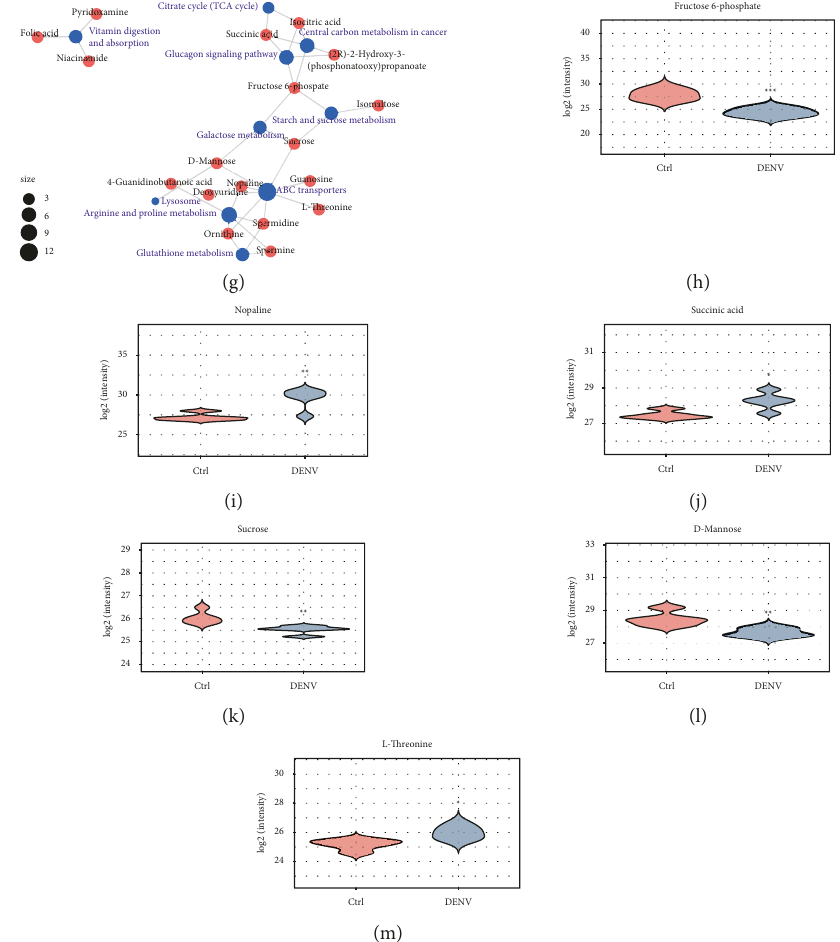
Figure 1: Urinary metabolite profiles reflect characteristics of DENV infections. Score plot of principal component analysis (PCA) performed using urinary metabolite data for all samples in (a) the positive-ion mode and (b) the negative-ion mode. Score plot of partial least squares (PLS) regression performed using metabolite data from samples in (c) the positive-ion mode and (d) the negative-ion mode. (e) Metabolite cluster heatmap of urine. The metabolites in urine were analysed by hierarchical clustering. Each vertical line represents a plasma sample, and rows represent metabolites. Urine samples from the same group of mice were aggregated. The relative content in the figure is displayed by different colours. The redder the colour is, the higher the expression, and the bluer the colour is, the lower the expression. The column represents the sample. (f), (g) The metabolomic view of pathway analysis using a metabolic analyser shows the most obvious metabolic pathway affected by DENV infection. (h–m) A violin diagram of metabolites was used to distinguish the DENV infection group from the control group. (h) Fructose 6-phosphate, (i) nopaline, (j) succinic acid, (k) sucrose, (l) D-mannose, and (m)